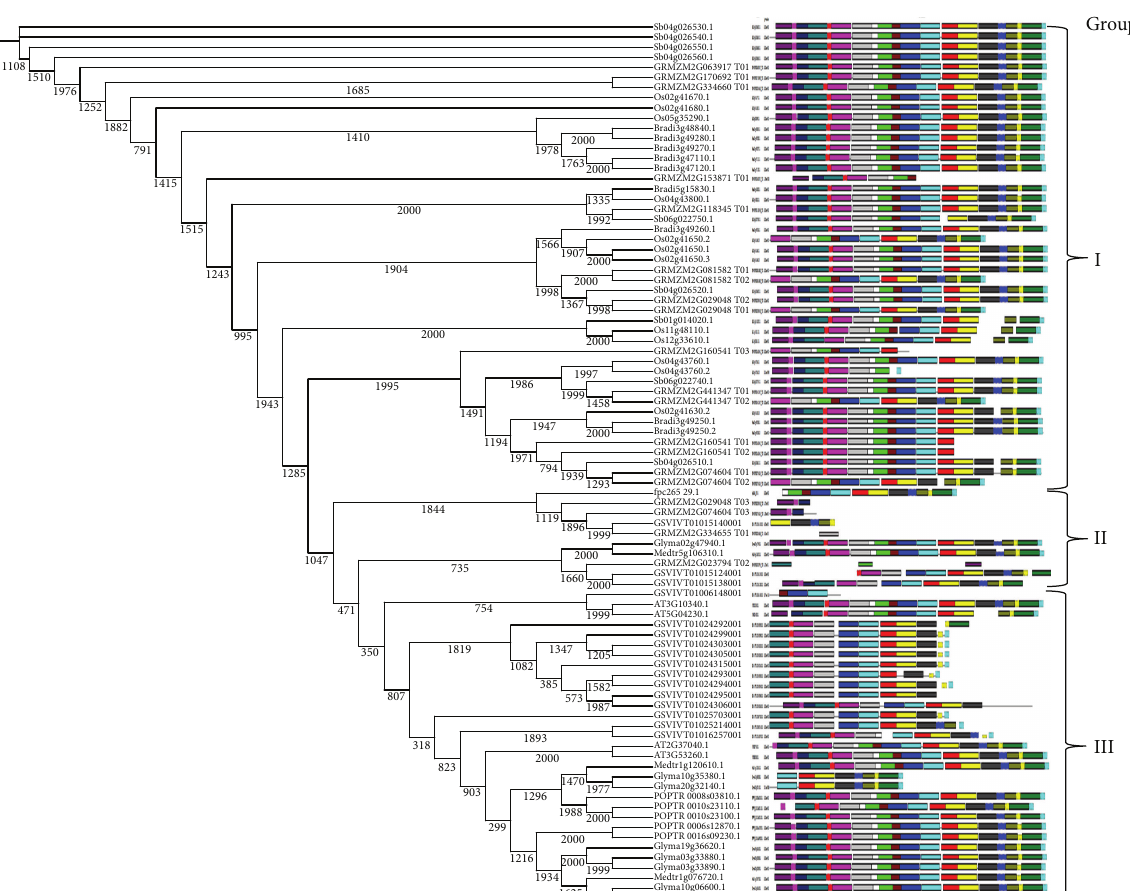
Figure4:SchematicdiagramofmotifdistributionofPALgenes.MEME4.6.0wasappliedtoshowthatdifferentsubgroupsweredistinguished by the motif distribution, which is consistent with the phylogenetic subgroups obtained by ClustalX 2.1. Numbers written below each node are bootstrap values derived from 2000 replicates. Twenty conserved novel motifs were shown with different colored